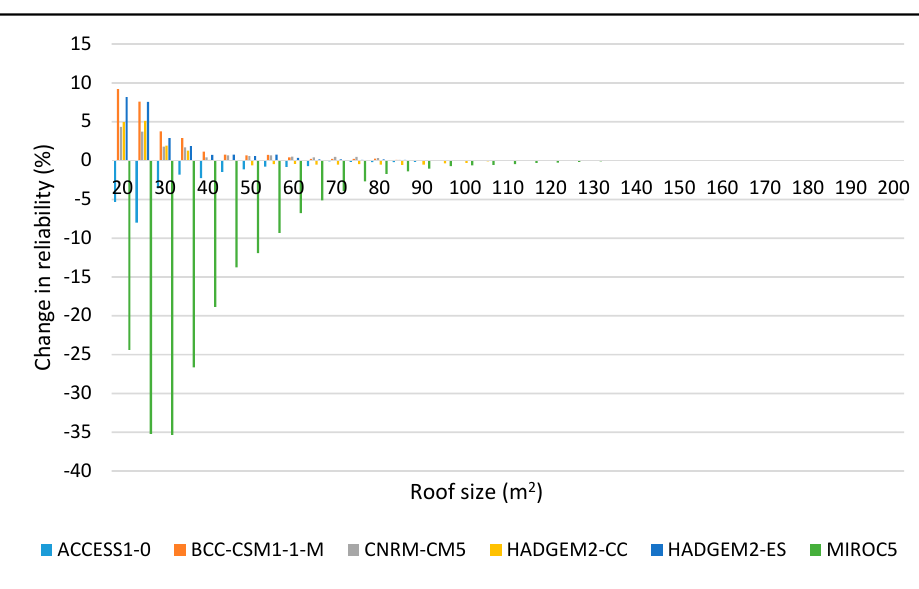
Figure 24. Change in reliability for MAM 2025–2055 period for 2 m 3 tank size.